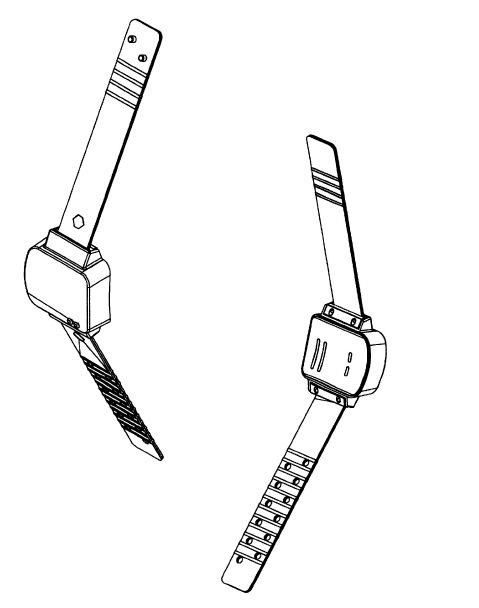
Figure 1. Patent watch/bracelet form USD535205S1